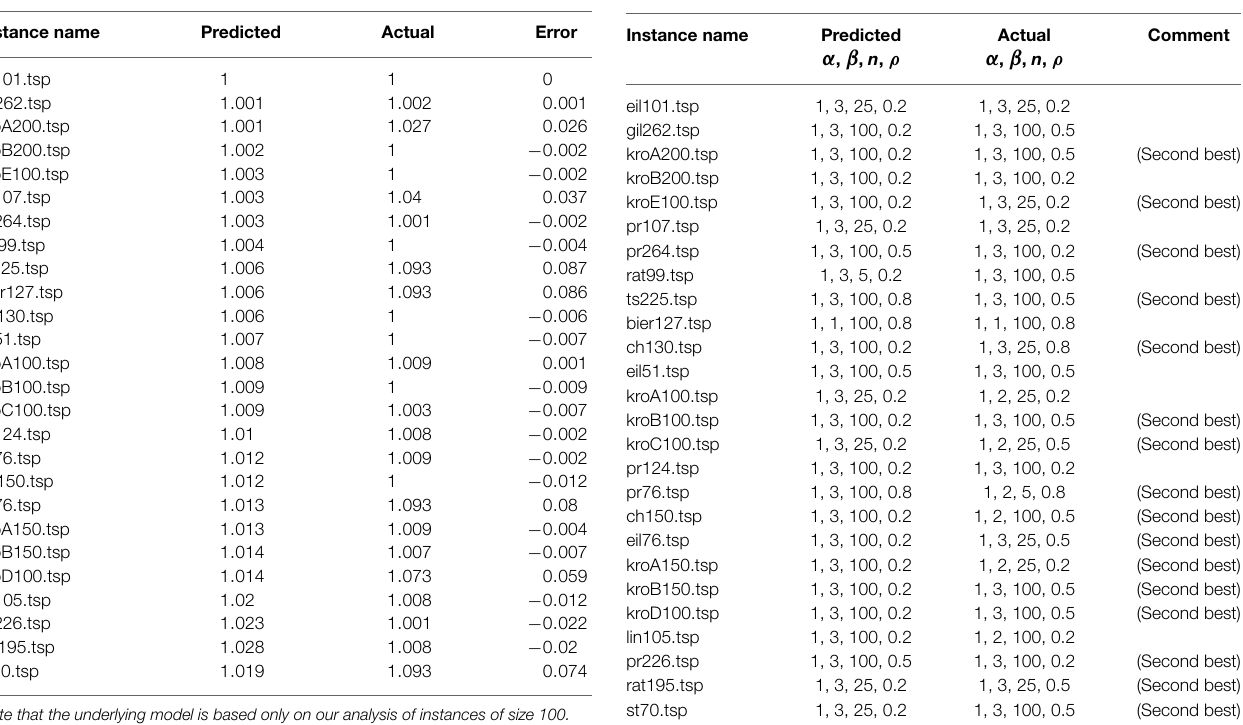
TABLE 2 | Predicted and actual approximation ratios for 26 TSPLIB instances of size in range 51–264 .